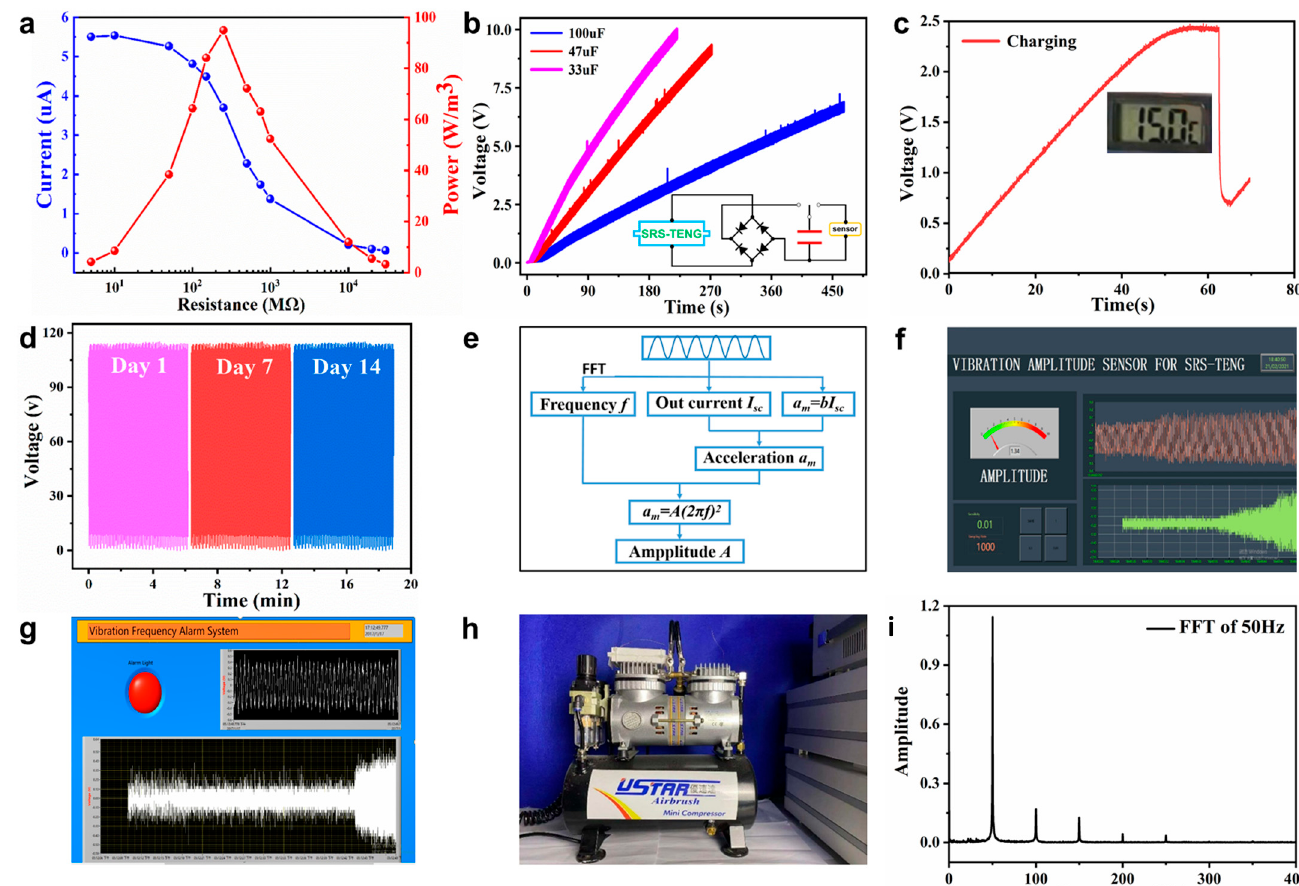
Figure 6. The demonstration of the SRS-TENG as a vibration energy harvester and self-powered vibration sensing and alarm system. ( a ) Current and output power density of the SRS-TENG under a vibration frequency of 30 Hz and an amplitude of 2 mm. ( b ) Voltage curves of different capacitors charged by SRS-TENG. ( c ) Voltage curve of the capacitor charged by the SRS-TENG powering a temperature sensor. ( d ) Robustness performance of the SRS-TENG after 14 days test. ( e ) The logic diagram of SRS-TENG for vibration amplitude and frequency sensing. Demonstration of ( f ) vibration amplitude sensing and ( g ) vibration frequency alarm system. ( h ) The SRS-TENG mounted on a commercial air compressor as a vibration sensor and ( i ) the FFT result of the voltage signal of the